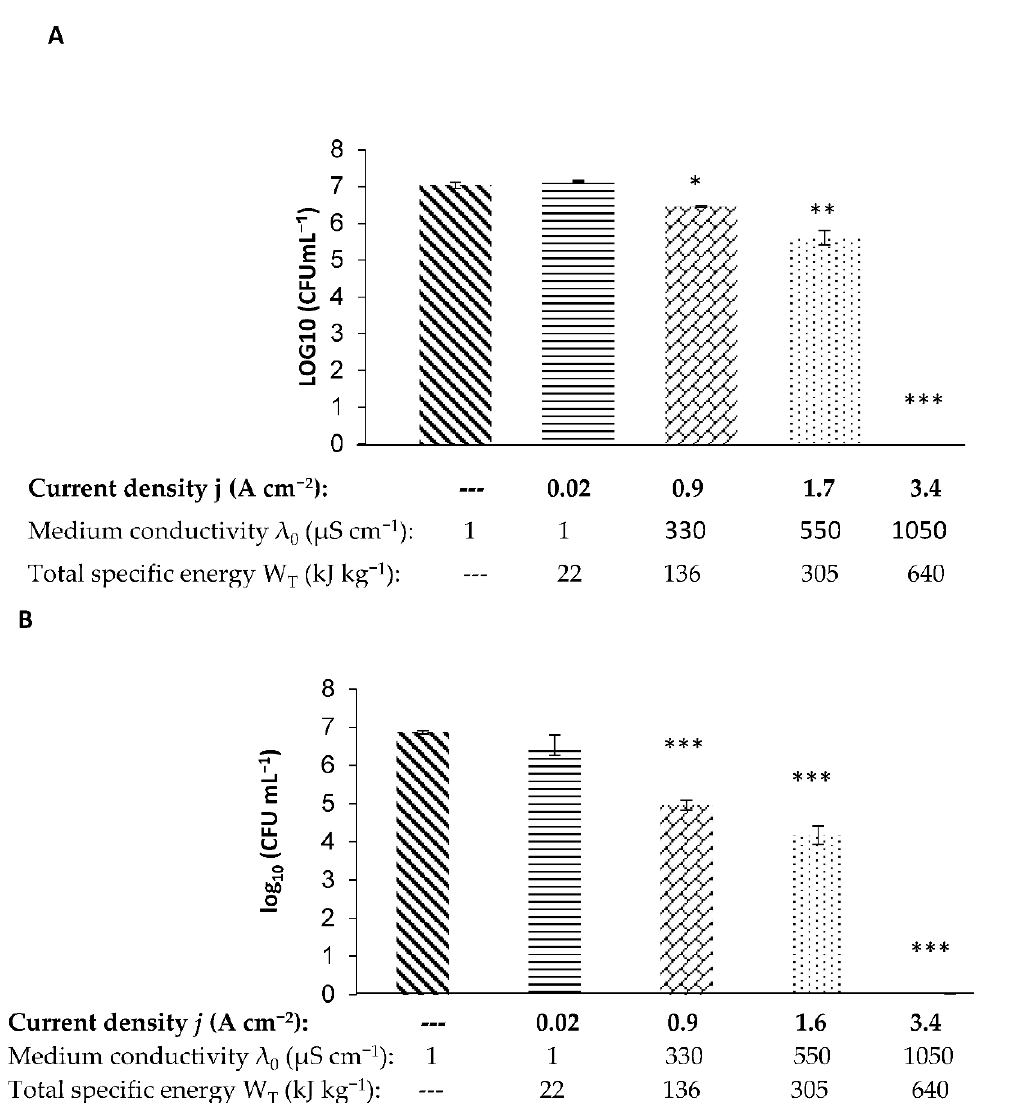
Figure 2. CFU (colony forming unit) counts of S. aureus ( A ) and P. putida F1 ( B ) as a function of pulsed electric field (PEF)-treatment in different current densities. The control column and the second column (0.02 A cm − 2 ) represent the CFU mL − 1 of bacterial cells that were suspended in UP water without PEF-treatment and with PEF-treatment, respectively. The remaining columns (0.9–3.4 A cm − 2 ) represent the CFU mL − 1 that were suspended in solutions with different current densities. p -value ( t -test): p < 0.05 *; p < 0.01 **; p < 0.001 ***.